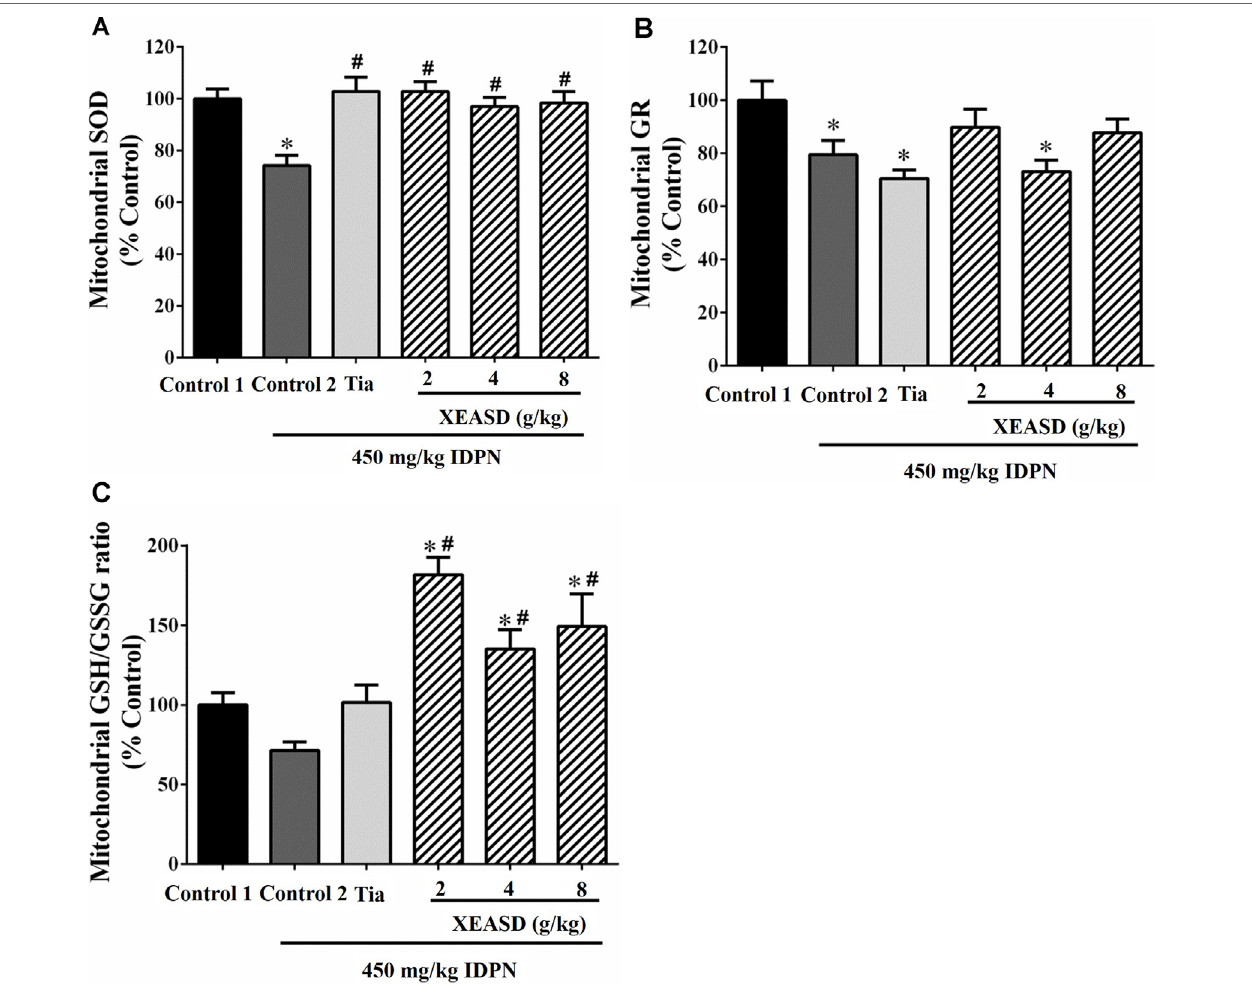
FIGURE 7 | Effects of XEASD treatment on brain mitochondrial antioxidant status in IDPN-induced TS mice. (A) Biochemical assay of MnSOD activity was performed as described in Materials and Methods. (B) Mitochondrial GR activity was measured as described in Materials and Methods. (C) Mitochondrial GSSH/GSSG ratio was measured as described in Materials and Methods. Control 1 represents normal control mice; control 2 represents IDPN-challenged control mice. Data are expressed as the percentage of non-challenged control 1 values. * P < 0.05, significantly different from the control 1; # P < 0.05, significantly different from the IDPN control 2. The value of GSH/GSSG ratio of control 1 (mean ± S.E.M.) was 31.3 ± 2.68. The values of GR activity of control 1 (mean ± S.E.M.) and SOD activity of control 1 (mean ± S.E.M.) were 21.1 ± 1.42 (mU/mg protein) and 5.69 ± 0.66 (U/mg protein),